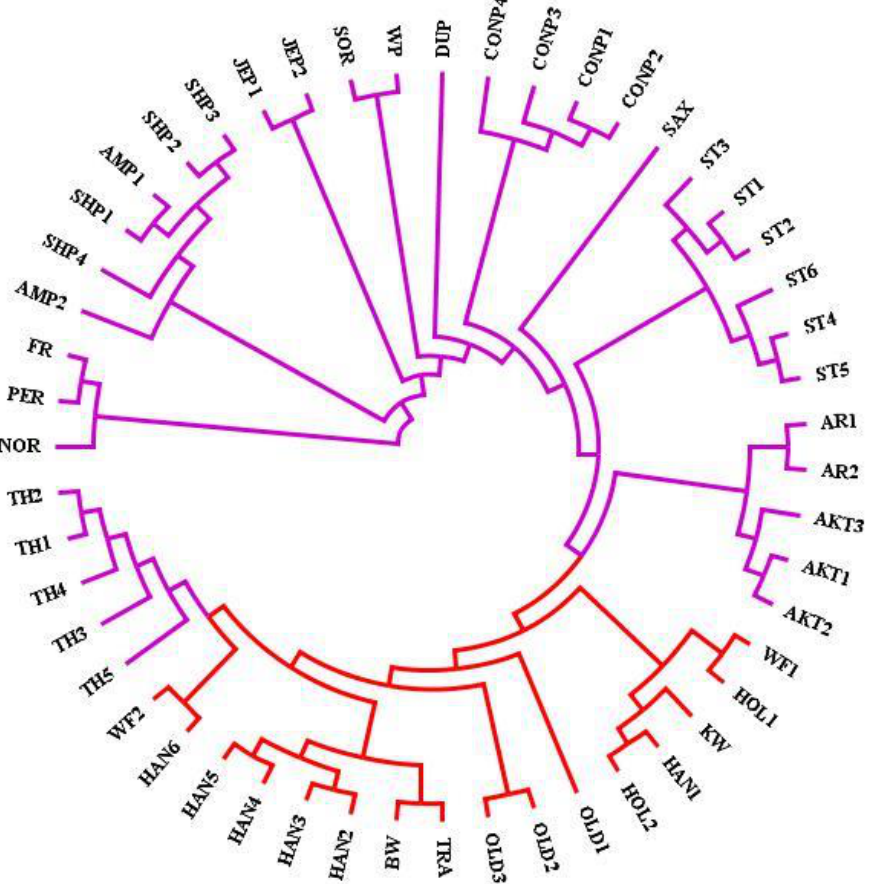
Figure 1. Neighbor-joining phylogenetic tree for sport and non-sport horse breeds. The sport breeds (red lines) are Baden-Wurttemberg (BW), Dutch warmblood (KW), Hanoverian (HAN), Holstein (HOL), Oldenburg (OLD), Trakehner (TR), and Westphalian (WF). Non-sport breeds (purple lines) are Akhal-Teke (AKT), American Miniature (AMP), Arabian (AR), Connemara pony (CONP), Dülmen pony (DUP), Friesian (FR), Jeju pony (JEP), Noriker (NOR), Percheron (PER), Saxon-Thuringian Heavy Warmblood (SAX), Shetland pony (SHP), Sorraia (SOR), Standardbred (ST), Thoroughbred (TH), and Welsh pony (WP).